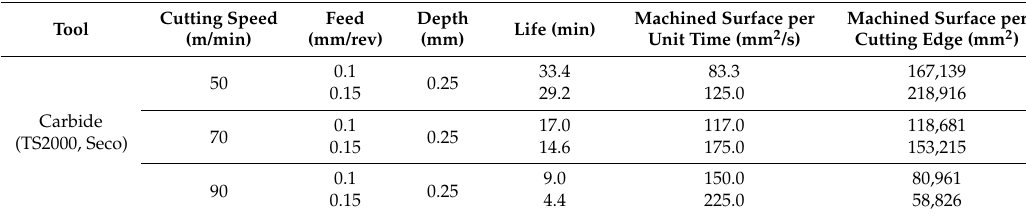
Table 3. Tool life in terms of cutting time (min), S mach.t (machined surface per unit time (mm 2 /s)), and S edge (machined surface per edge (mm 2